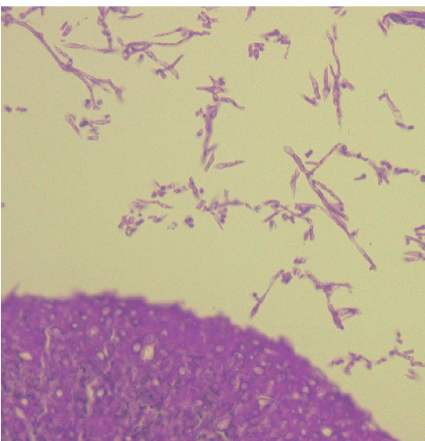
Figure 4: Sinus mucosal biopsy hematoxylin and eosin staining (magnification 400). CT: compound tomography, MRA: magnetic resonance angiography, MRI: magnetic resonance imaging, DWI: diffusion weighted